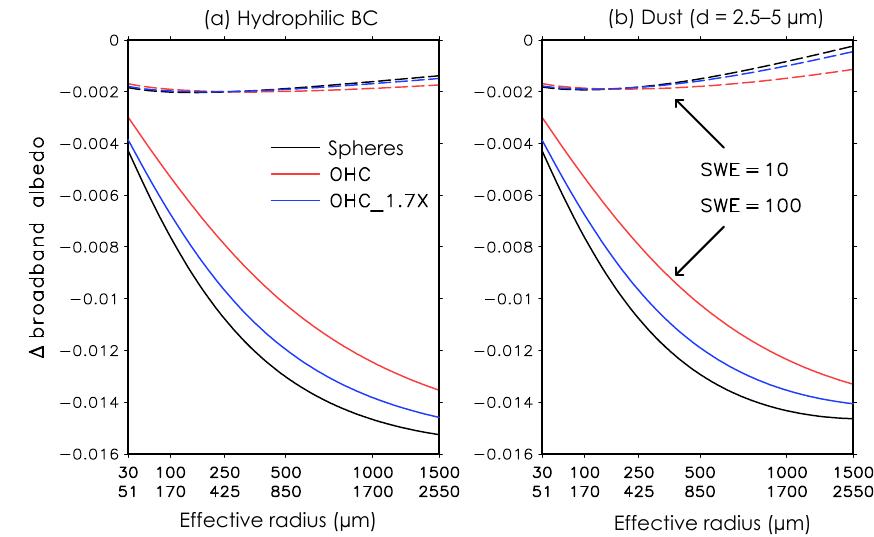
Figure 13. Impact of absorbing aerosols on snow broadband albedo as a function of snow grain effective radius r e for (a) hydrophilic BC and (b) mineral dust (second-largest dust size bin considered in SNICAR corresponding to particle diameters of 2.5–5µm). The solid lines are for a snow water equivalent SWE = 100kgm − 2 and the dashed lines are for SWE = 10kgm − 2 , while the black, red, and blue colours correspond to spheres, the OHC, and the OHC with r e multiplied by 1.7, respectively. The upper scale on the x axis gives r e for the former two cases and the lower scale for the last case. The results were computed using the delta-Eddington method in the visible region and the delta-hemispheric mean method in the near-infrared, assuming direct incident solar radiation with a zenith angle of 60 ◦ and with a spectral distribution corresponding to a cloud-free midlatitude winter atmosphere, with an underlying surface albedo of 0. The aerosols are homogeneously mixed in snow, with mass-mixing ratios selected so that for both aerosol species, the albedo reduction equals 0.01 for spherical snow grains with r e = 200µm when SWE = 100kgm − 2 (24 ppb for hydrophilic BC and 8120ppb for